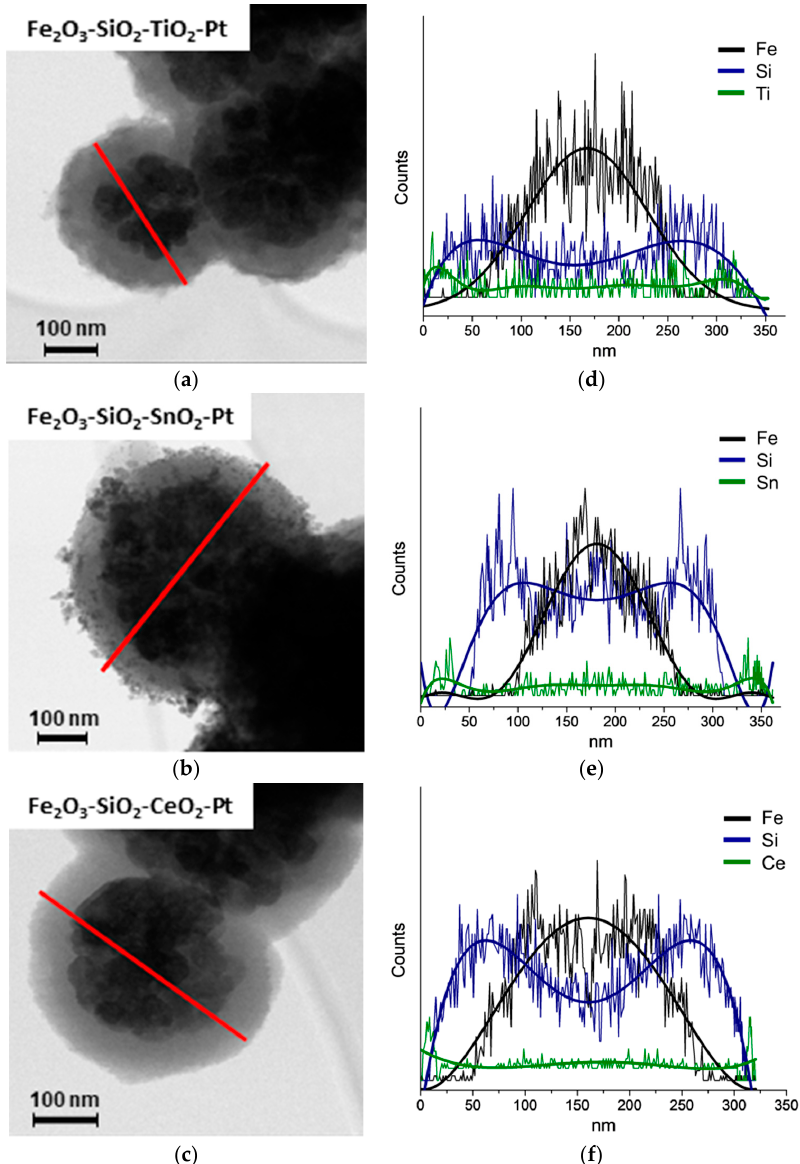
Figure 1. HR-TEM characterization for the synthetized core-shell materials. ( a – c ) HR-TEM micrographs and ( d – f ) STEM-EDX Fe (black), Si (blue), MeO 2 ; Me = Ti, Sn, Ce (green) for the –MeO 2 (Me = Ti, Sn, Ce) structures.